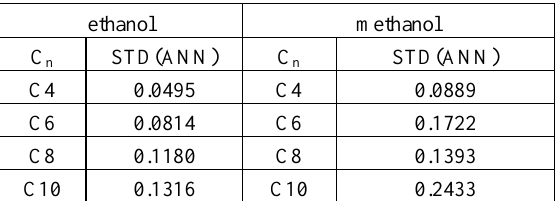
Table 5.1 Standard deviation of ANN prediction in compositional viscosity for each individual binary [C n - mim][NTf 2 ]-ethanol and methanol system at temperature